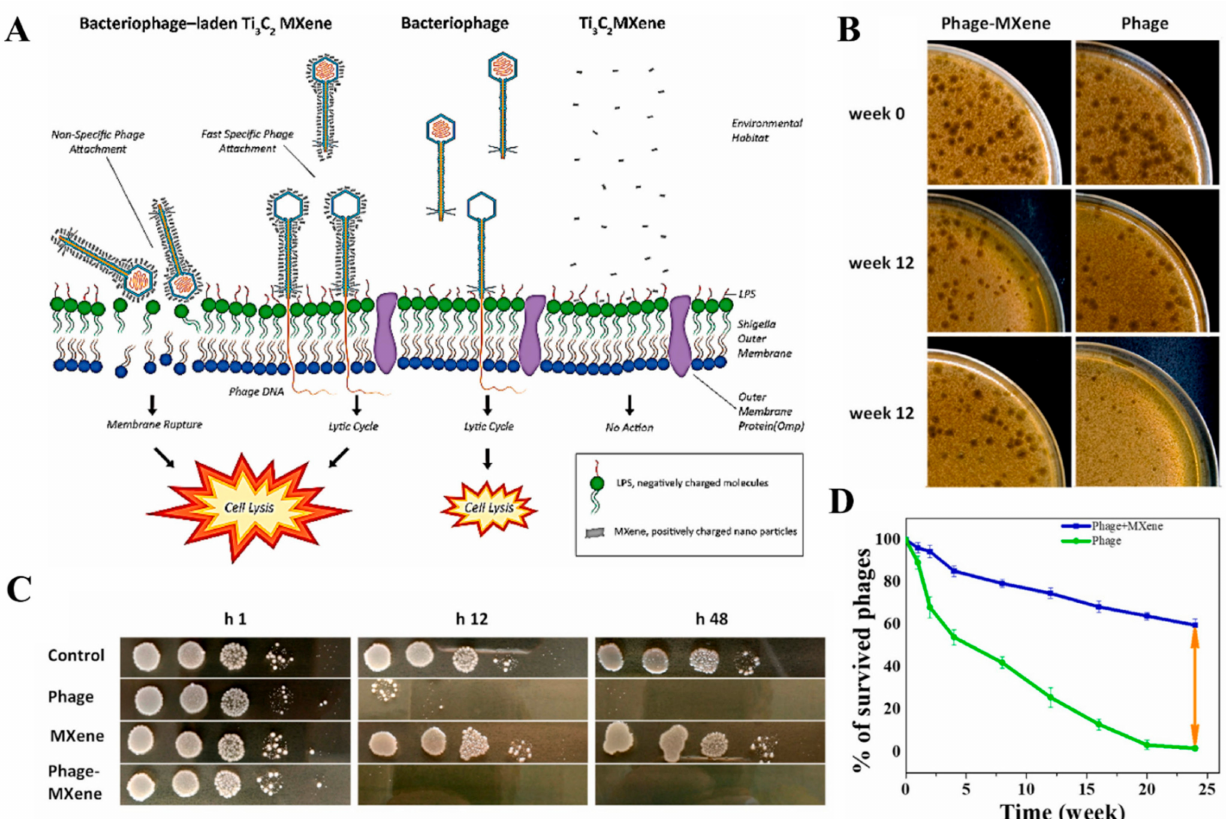
Figure 5. ( A ) Schematic illustration of the physical interaction of MXene-bacteriophage with bacteria leading to antimicrobial properties. ( B ) Pictures of bacteriophage spot assay indicating the improved stability of bacteriophage laden by MXene compared to the bacteriophage over different times. ( C ) Pictures of Shigella spot assay indicating the greater bacteria viability reduction in the presence of bacteriophage laden by Ti 3 C 2 T x MXene compared to bacteriophage over different times. ( D ) The longevity of MXene-laden bacteriophage and free bacteriophage in water at 25 ◦ C, over a period of 24 weeks incubation. Reprinted with permission from Ref. [100]. Copyright © 2022